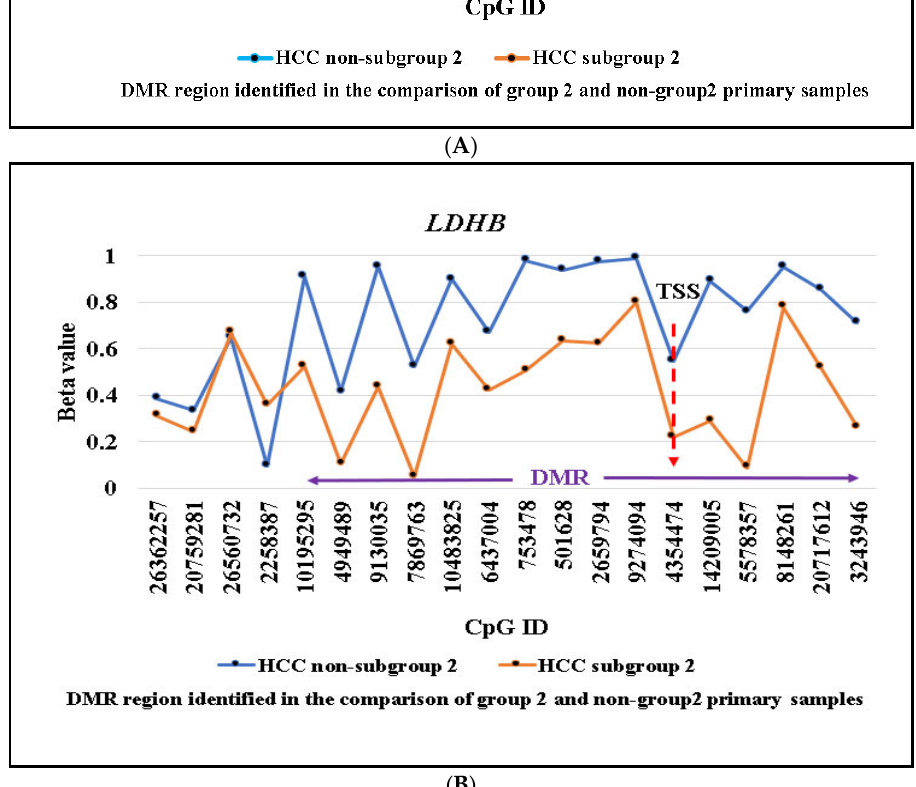
Figure 4. DNA methylation levels at DMR and non-DMR of two candidate SLGs– TIAM1 ( A ) and LDHB ( B ) using Infinium MethylationEPIC array. ID: The identification number refers to the location of individual CpG which can be used as a reference database (CpG loci lack of nomenclature). TSS: transcription start site, indicated by red arrow.